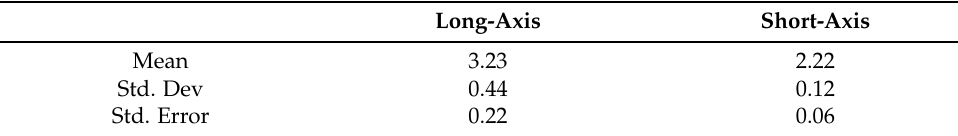
Figure A1. Microscopy images of tissue biopsies inside culture chambers. Images were taken under a Olympus BX41 microscope at 1.25 × . Table A1. Mean biopsies dimensions for fibrotic tissue ( n = 4).